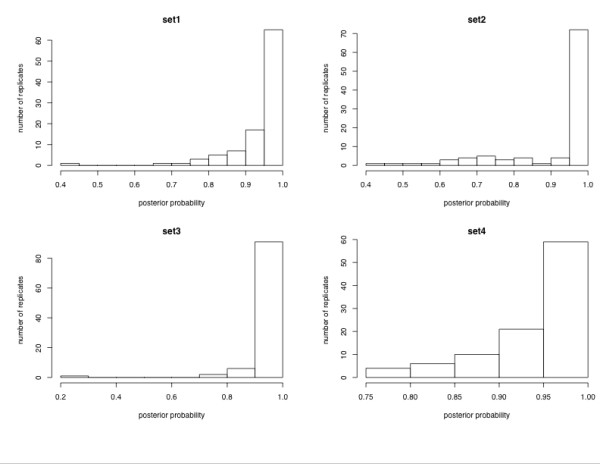
Distribution of the posterior probabilities for the correct site class classification in each of the simulated data sets. Each data set has 100 replicated and they were analyzed using Model A1 and the volume partition.